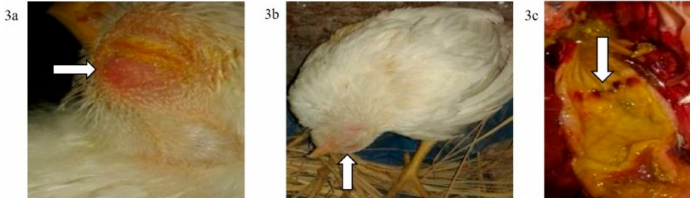
Figure 3. ( a ) Conjunctivitis and swelling of the head of a broiler chicken infected IN (G2c); ( b ) torticollis in a broiler chicken infected IN with NDV-VIId (G2c); ( c ): petechial haemorrhage at the junction between the oesophagus and proventriculus of a broiler chicken infected IN with NDV-VIId